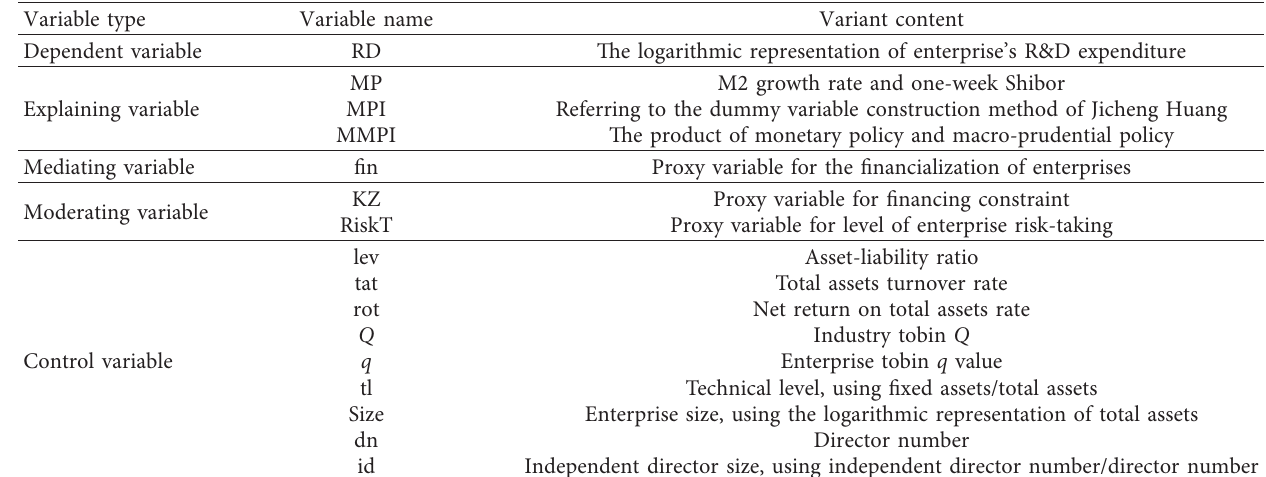
Table 1: Variable descriptions.